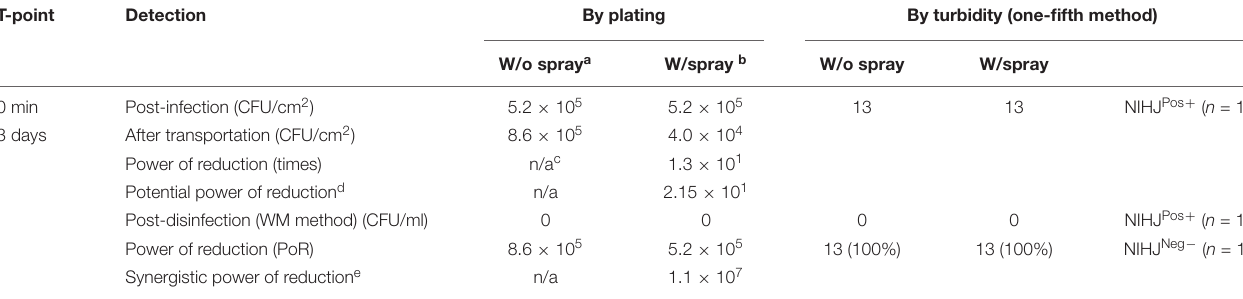
TABLE 3 | Effect of the spray method on NIHJ strain (non-EHEC), artificially contaminating two beef legs, and the synergistic effect of both spray and WM methods.